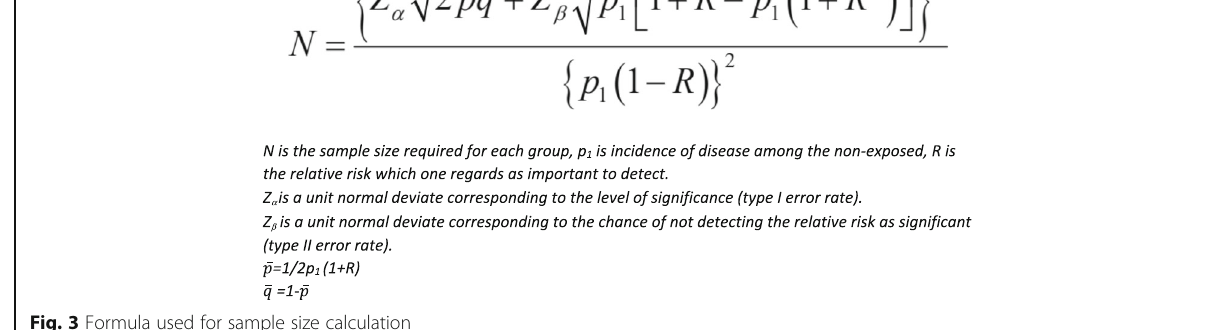
Fig. 3 Formula used for sample size